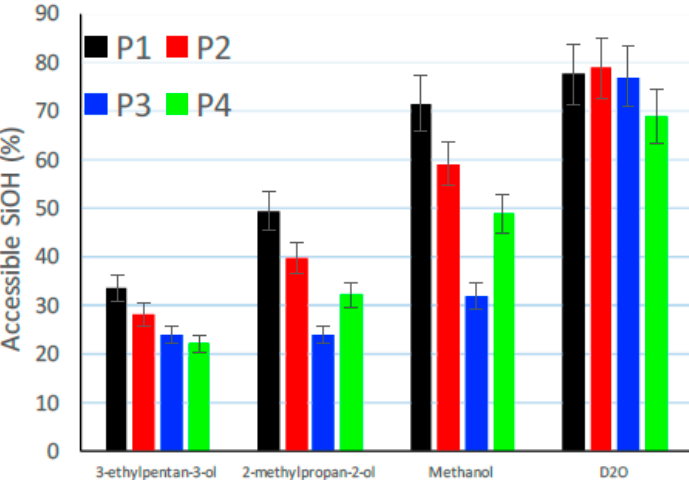
Figure 12. Accessible amount of silanol groups (in %) of 158GR190 in four different forms: P1-black (reference), P2-red (dried at 105 °C for 2 h), P3-blue (compressed with 125 MPa) and P4-green (dried and compressed with 125 MPa) [34].